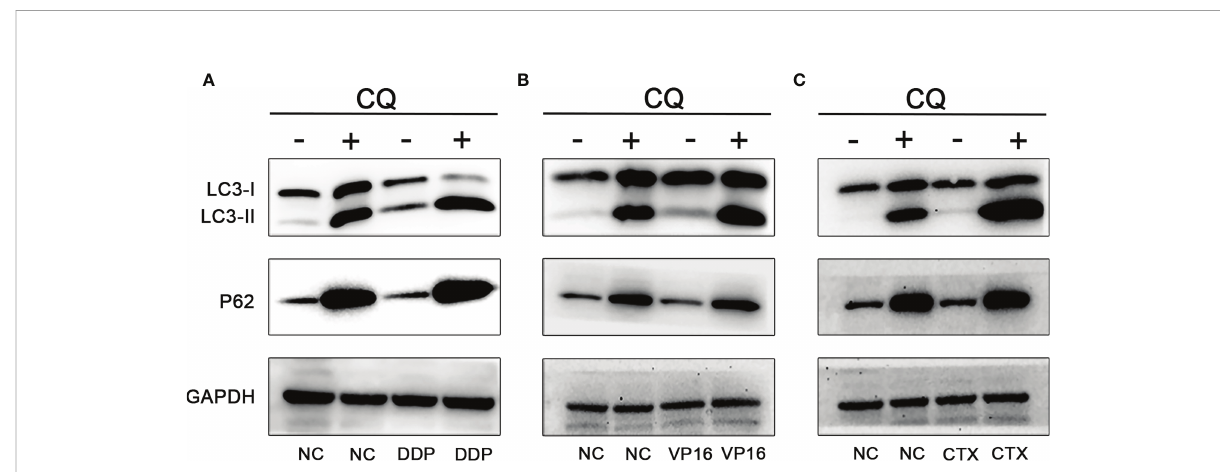
FIGURE 3 Effect of CQ on chemotherapeutic induced autophagy. Effect of CQ on autophagy after DDP (A) , VP16 (B) and CTX (C) acted on neuroblastoma, the expression of LC3-I and LC3-II increased, while the expression of P62 decreased. After combined with CQ, the expression of LC3-I and LC3-II further increased, and the latter increased more signi fi cantly. P62 expression level was increased due to inhibition of autophagy and decreased